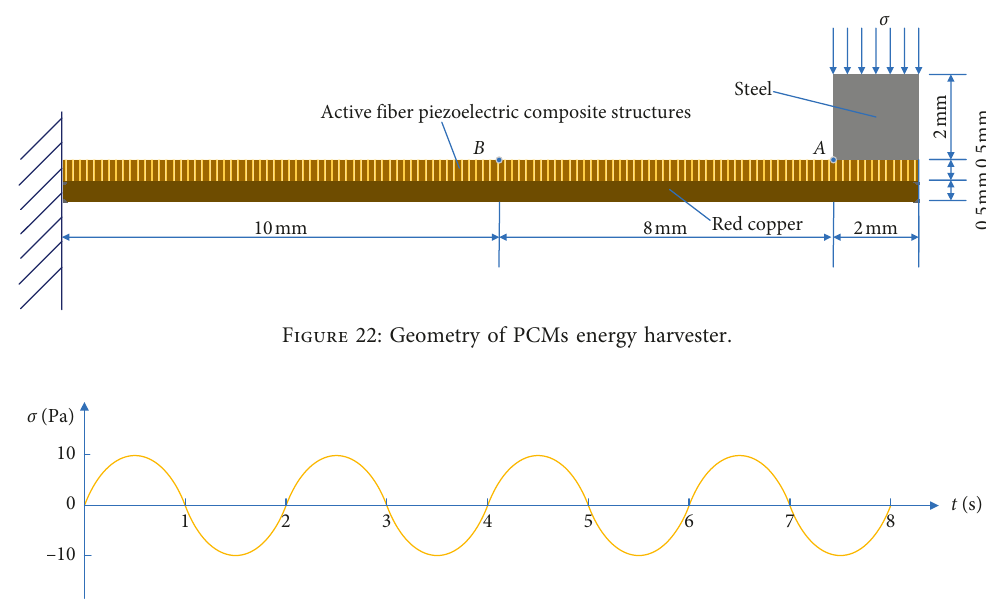
Figure 23: Sine-wave load at top surface of